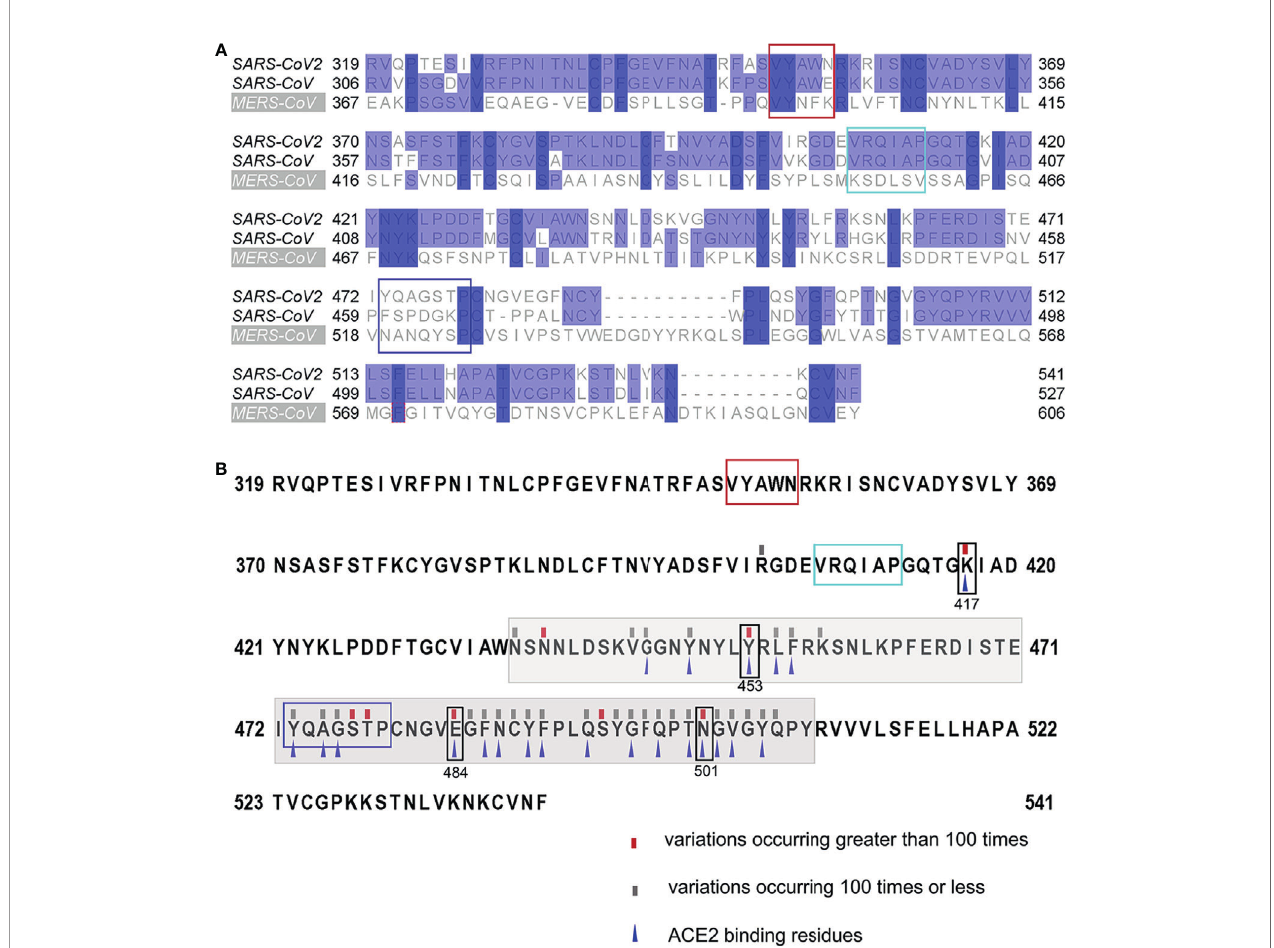
FIGURE 6 | Conservation of the identi fi ed linear B-Cell epitopes. (A) Multiple sequence alignments of the RBDs of SARS-CoV-2 (Wuhan-Hu-1), SARS-CoV (WH20) and MERS-CoV (HCoV-EMC). (B) Mutations found in the RBDs of the currently circulating SARS-CoV-2 strains. All receptor binding site changes reported in GISAID (updated on 2021-01-28) were listed in the fi gure. The red rectangles indicated variations occurring greater than 100 times at the site. The grey rectangles indicated variations occurring 100 times or less at the site. The grey shading indicated the sequence of the RBM. The blue triangles indicated the residues that interact with ACE2. The box indicated the identi fi ed epitopes, epitope 351 YAWN 354 (red), epitope 407 VRQIAP 412 (cyan), epitope 473 YQAGSTP 479 (blue). The black boxes indicated the mutation sites in RBD, included K417N, E484K and N501Y of the novel variant 501Y.V2, N501Y of the B.1.1.7 variant, and Y453F of mink-associated variant